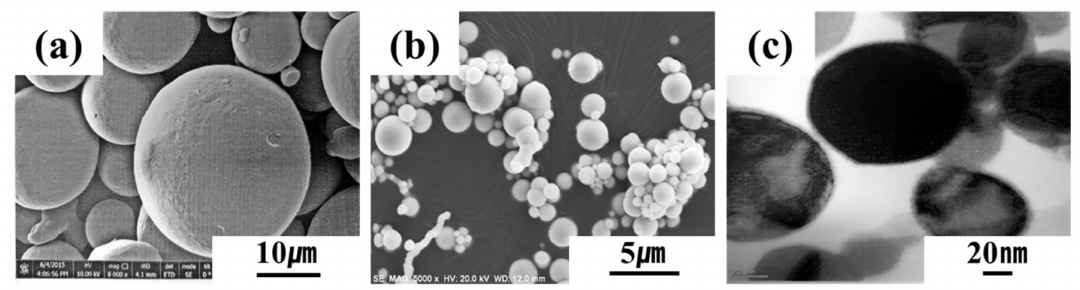
Figure 3. SEM image analysis of iron-based soft magnetic powders used in magnetic bulk composite